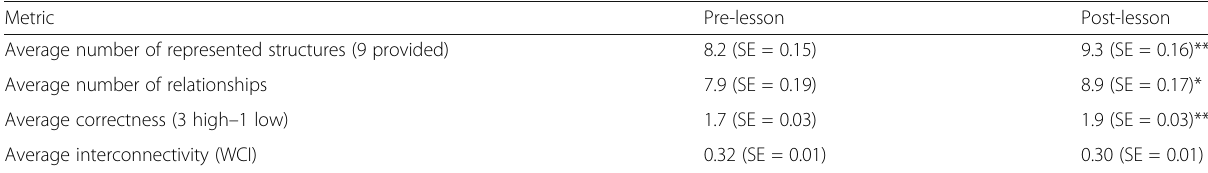
Table 1 Differences in number and quality of represented structures and relationships between pre- and post-lesson conceptual models (SE = standard error of the mean)